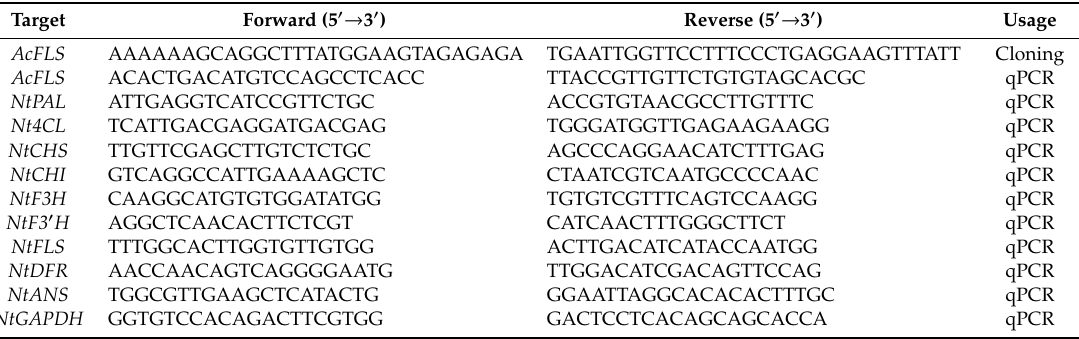
Table 1. List of primers used for cloning and